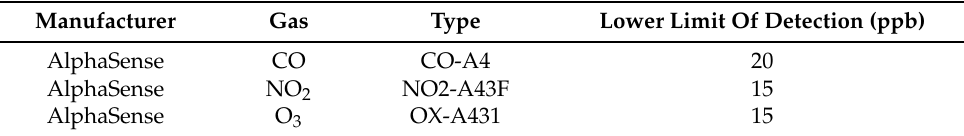
Table 4. Device under test lower limits of